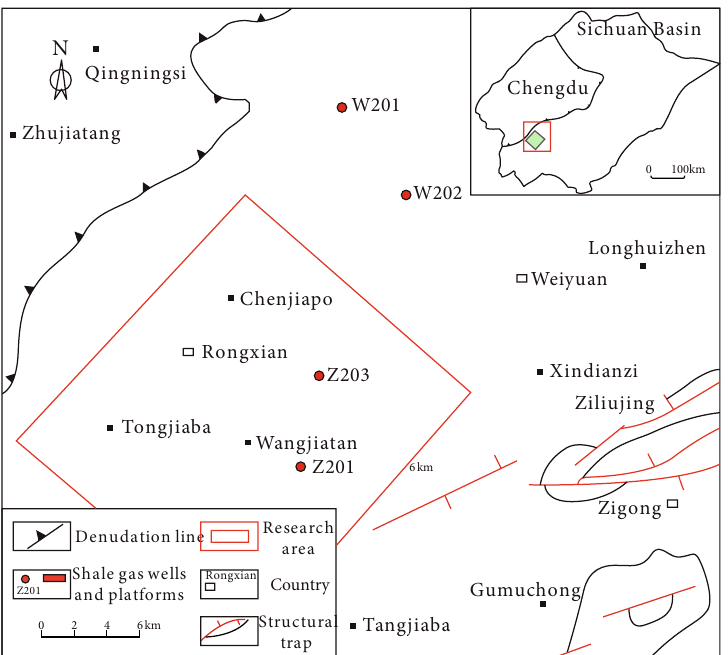
Figure 1: Geological map and sampling location of the investigation area, southern Sichuan Basin (modi fi ed after